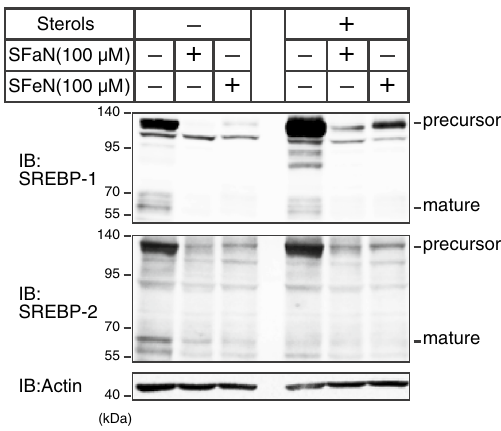
Figure 3. SFaN reduces SREBP precursor forms under cholesterol-enriched conditions. Huh-7 cells were sterol-depleted or enriched by incubation in medium D or medium E for 16 h, respectively, and then treated with 100 μM SFaN or SFeN. After incubation for 3 h, whole-cell extracts underwent immunoblotting (IB) with anti-SREBP-1 (2A4), anti-SREBP-2, or anti-β-actin antibodies. Full-length images are presented in Supplementary Fig.